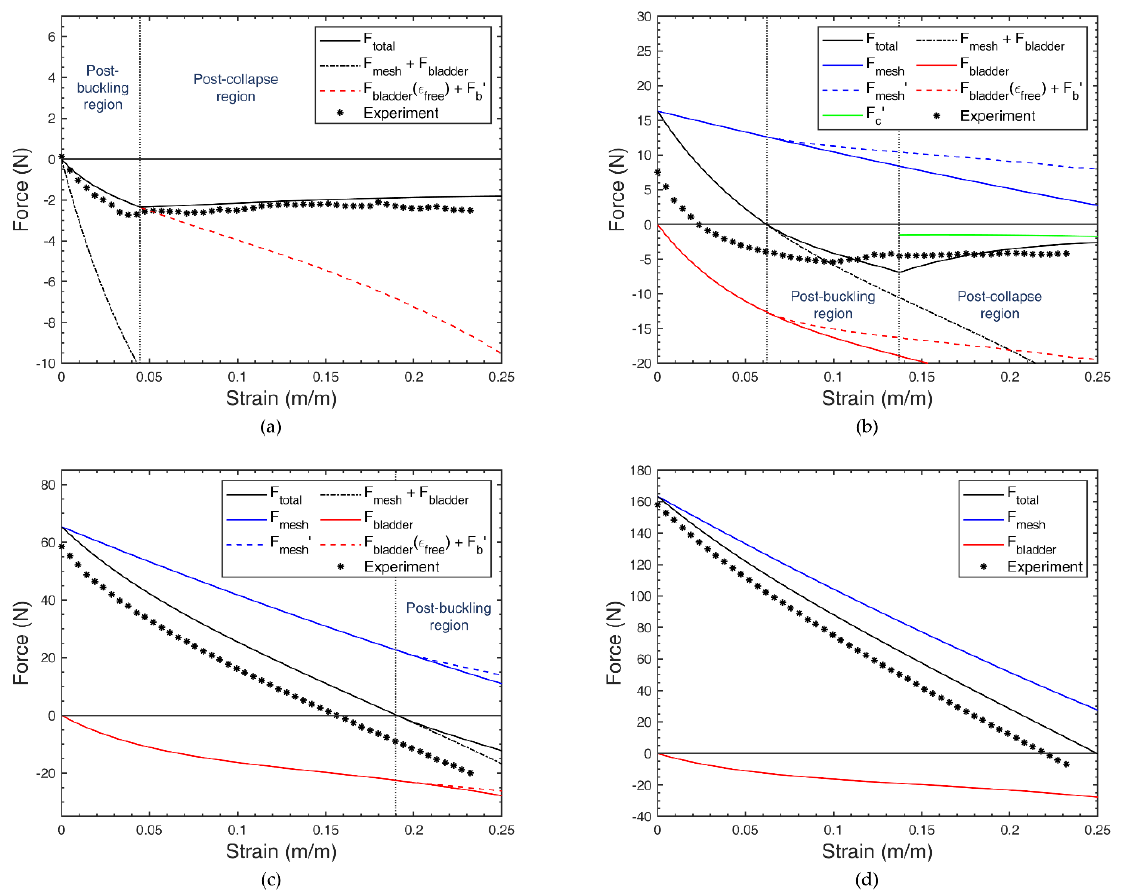
Figure 6. Breakdown of model forces along with corresponding experiment results for ( a ) 0 kPa, ( b ) 34.5 kPa, ( c ) 137.9 kPa, and ( d ) 344.7 kPa. The resultant force from the piecewise model is shown in solid black as well as force components shown in Equation (27).